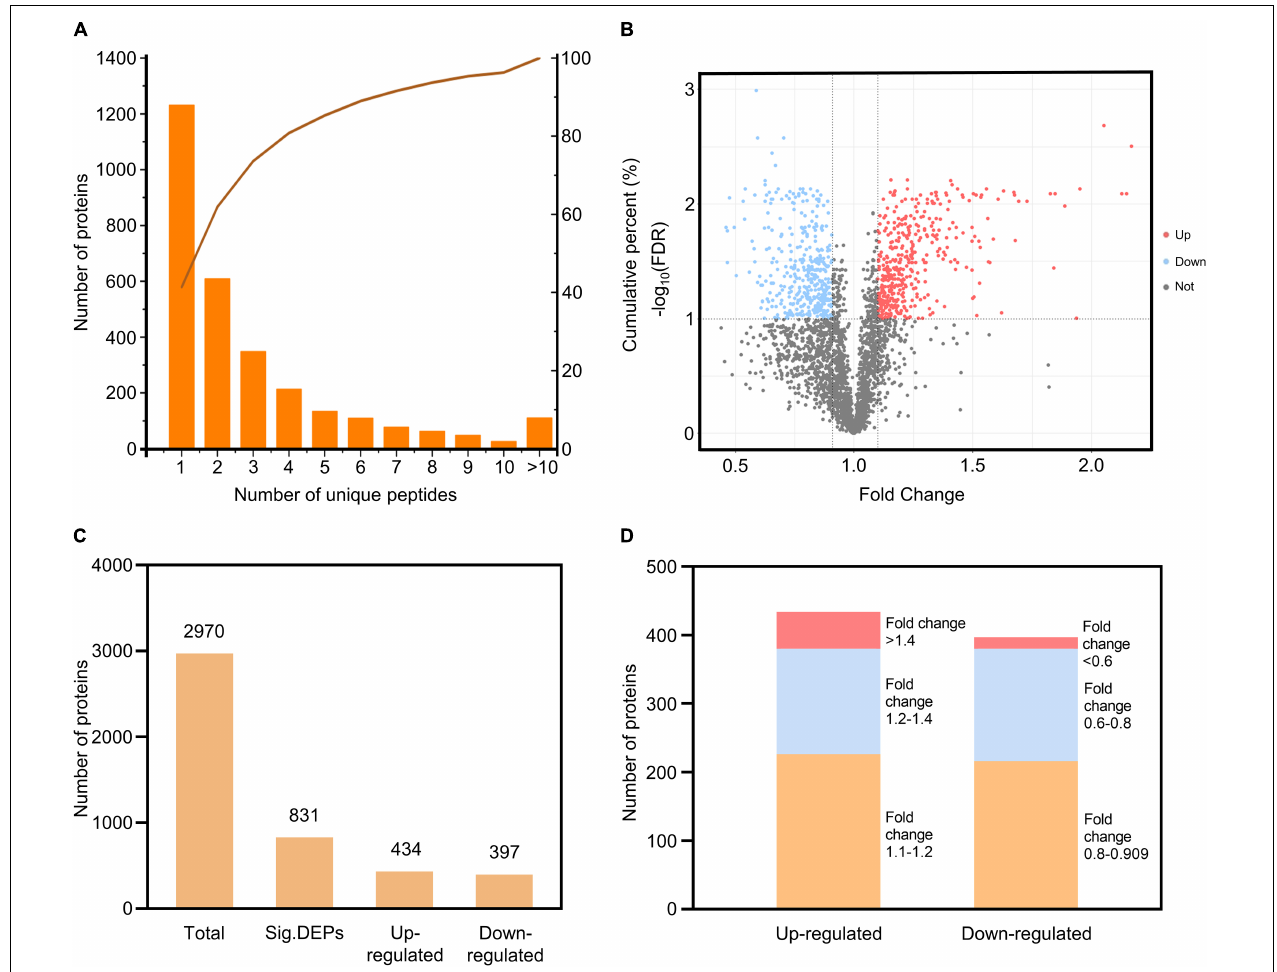
FIGURE 2 | Quantitative identification of proteins from the iTRAQ analysis. (A) Distribution of the number of unique peptides for the identified proteins. The X -axis is the scope of the unique peptides, the left Y -axis is the number of proteins, and the right Y -axis is the cumulative percent. (B) Volcano plot of the proteins identified. The X -axis specifies the fold change between 24 h/0 h, and the Y -axis specifies the -log10 (FDR); upregulated, downregulated and non-significant proteins are shown as red, blue, and gray dots, respectively; gray vertical and horizontal lines reflect the filtering criteria (fold change > 1.1 or < 0.909 and FDR < 0.1). (C) The number of total proteins and DEPs (including upregulated and downregulated). (D) The distribution of DEP fold